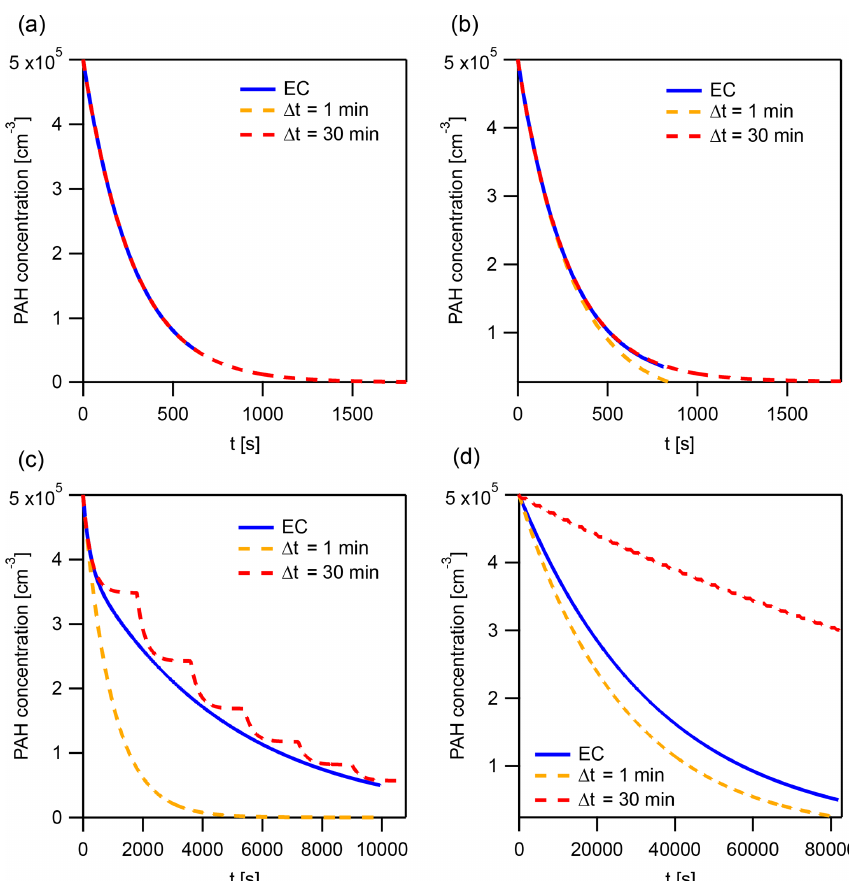
Figure A5. The explicitly coupled (EC) solution and instantaneous-equilibration (IE) solutions with time steps (cid:49)t = 1 and 30min at specific points for the evaluation of the error metric E loss (Fig. 8a and b). These points represent a horizontal cross section of Fig. 8 at [ O 3 ] = 2 . 5 × 10 12 cm − 3 and the following k des : (a) 10 − 6 . 3 , (b) 10 − 4 . 7 , (c) 10 − 3 . 1 , and (d) 10 − 1 . 5 s − 1